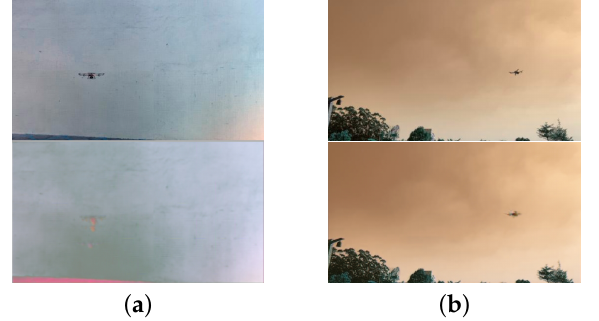
Figure 6. Two images generated by two sets of frames with different frame spacings (the actual frame is at the top while the generated frame is at the bottom): ( a ) frame generated by the discontinuous set, whose quality is significantly different from that of the actual frame; ( b ) frame generated by the continuous set, whose quality is significantly improved compared to that in ( a